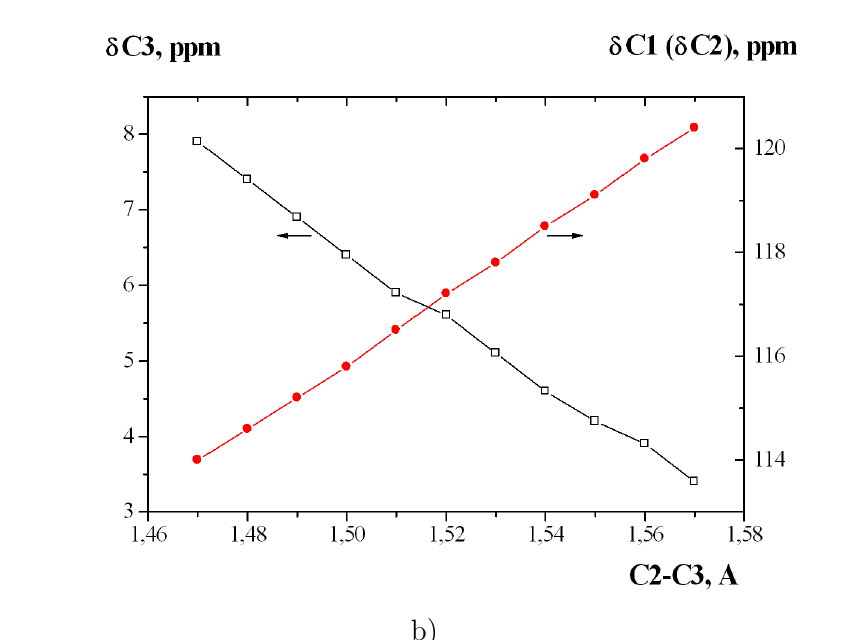
Fig. 2 Dependence of the GIAO calculated C1. C2 and C3 chemical shifts of 1 on the C1-C2 (a) and C2-C3 (b) bonds lengths. Chemical shifts calculated at B3LYP/6-311+G(2d,p) level. Constrained optimization performed at B3LYP/6-31G(d) level with Cs symmetry point group (equal C2-C3 and C1-C3 bonds